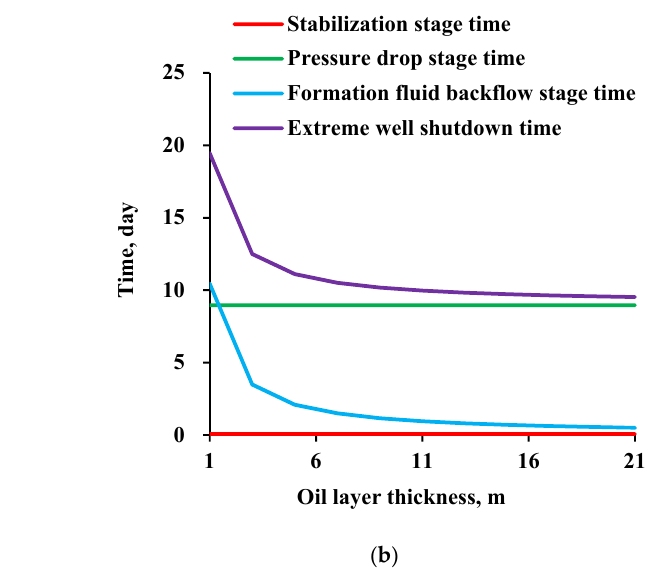
Figure 6. Effect of formation permeability and reservoir thickness on the limit shut-in time of water proof compound. ( a ) Influence of formation permeability on the limit shut-in time of water proof compound; ( b ) Influence of reservoir thickness on the limit shut-in time of water proof